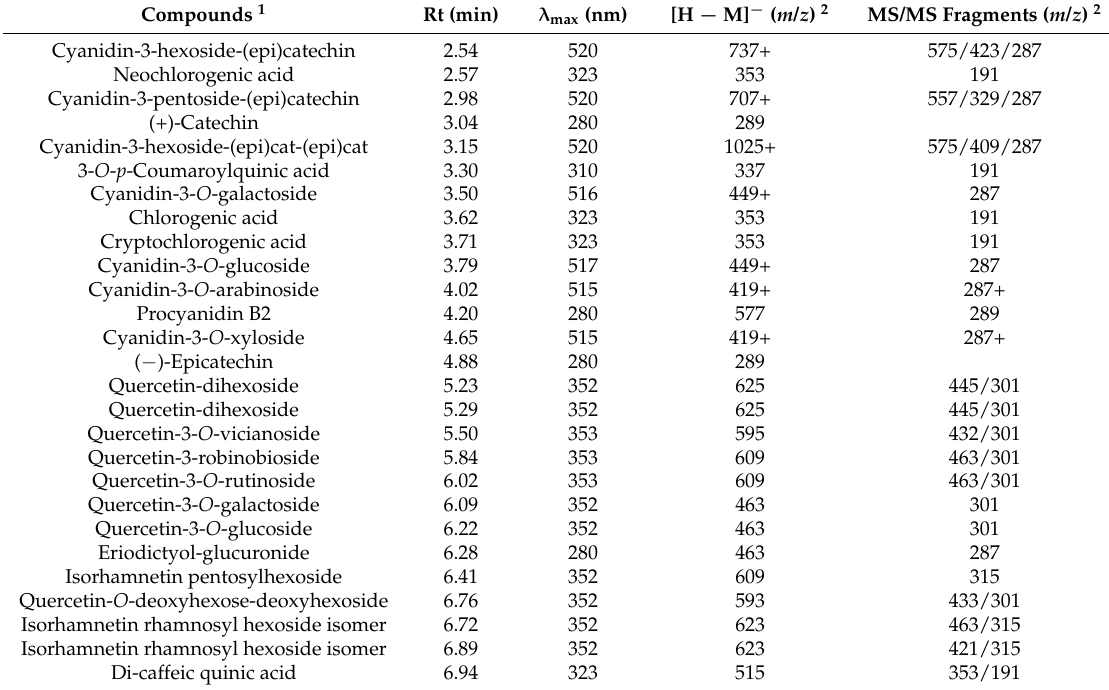
Table 2. Groups of phenolic compounds identified by LC-PDA-ESI-MS/MS in black chokeberry